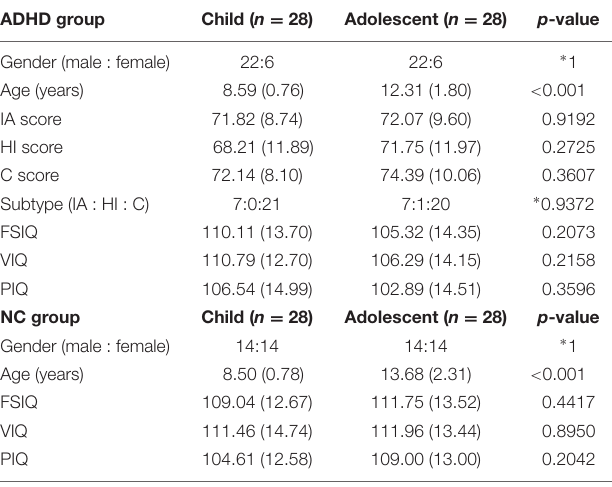
TABLE 1 | Demographic data of child and adolescent subjects in the attention deficit hyperactivity disorder (ADHD) and normal control (NC) groups (means and standard deviations are